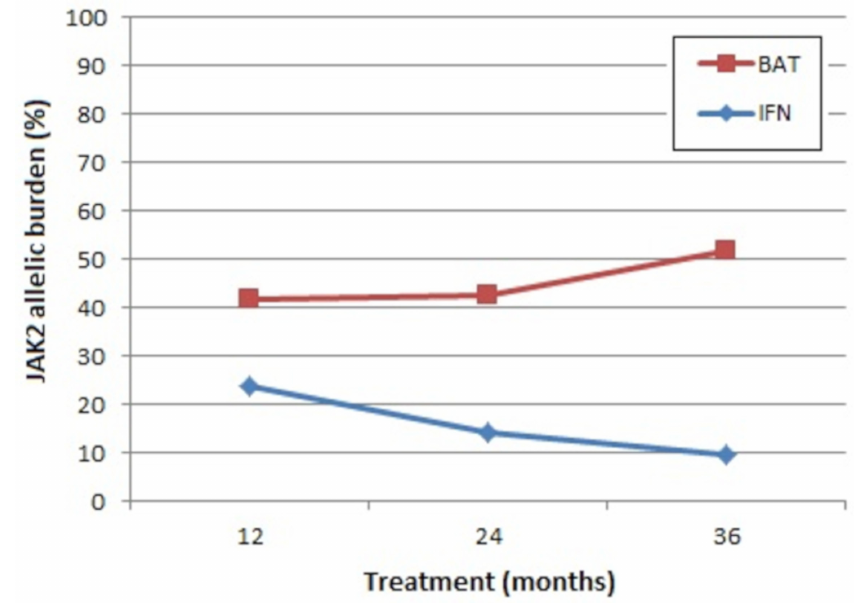
Figure 2. Mean absolute levels of JAK2 allelic burden. BAT: best available therapy (100% of the patients received hydroxyurea at least once), IFN: pegylated interferon-alpha 2b. Representation of results from CONTINUATION-PV (adapted from